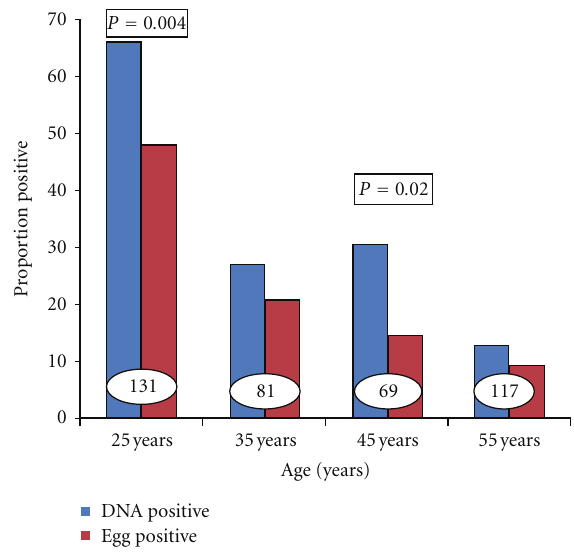
Figure 1: The proportion of Schistosoma haematobium cases diag- nosed by demonstration of eggs or schistosome-specific DNA in the urine. 398 specimens were collected from villagers in western Nigeria where the parasite is endemic. Numbers in table = number examined, P values given where